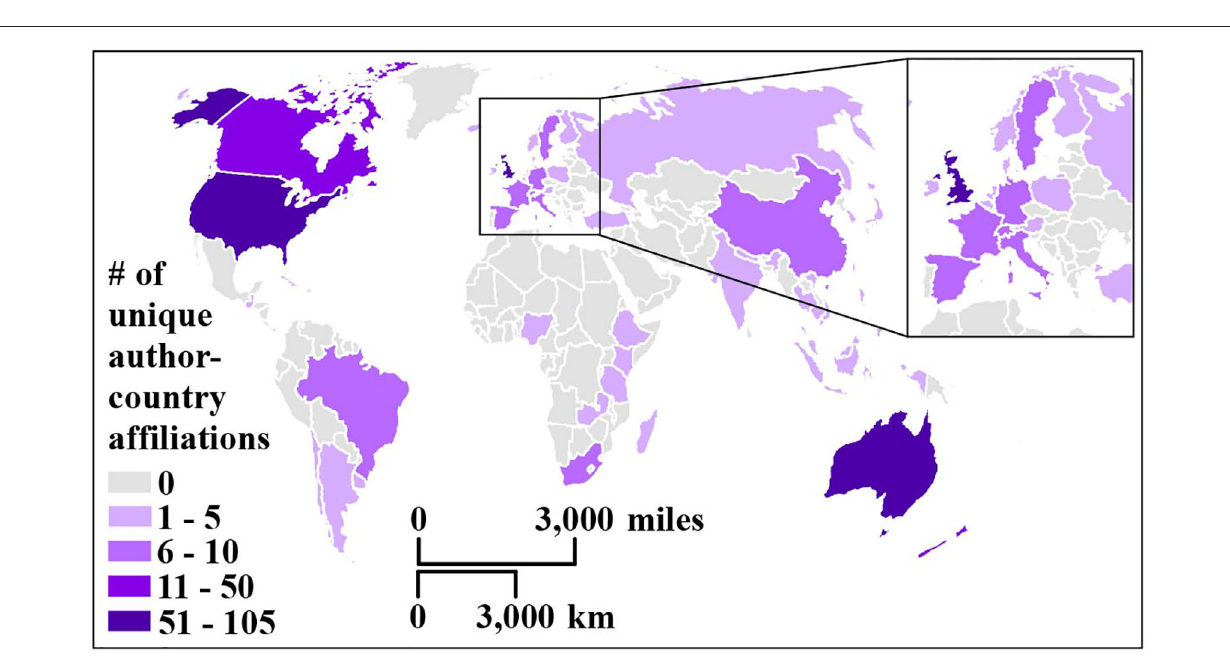
authors may not choose to ascribe the planetary health keyword to their work when publishing in other journals. Second, based on conversations with researchers attending planetary health